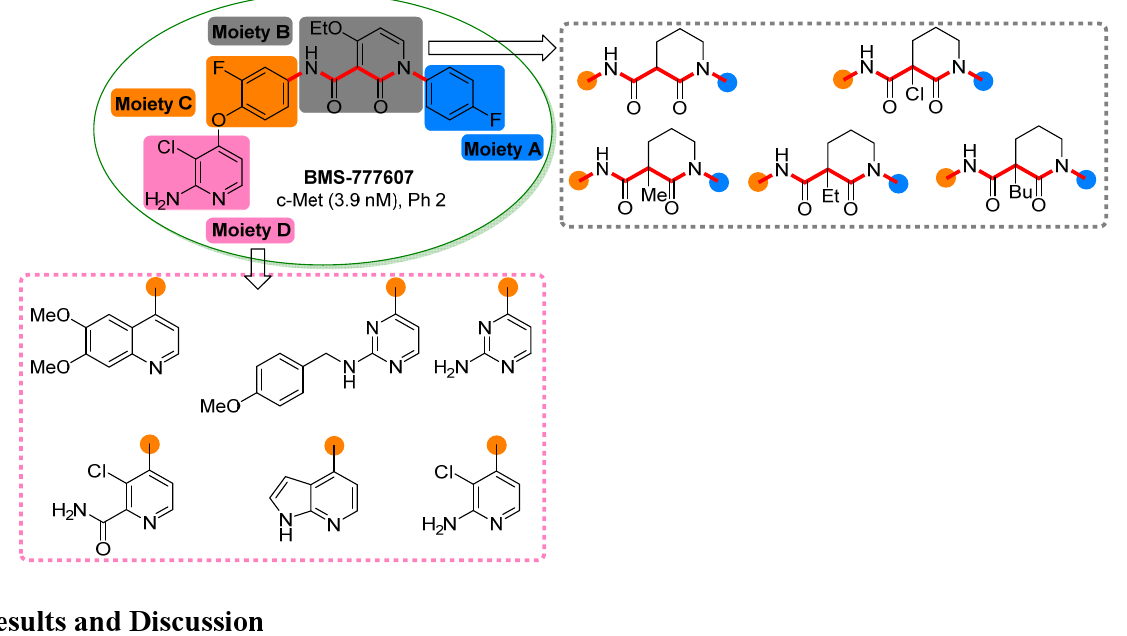
Figure 2. Scaffolds used for the structural optimization based on BMS-777607 in this